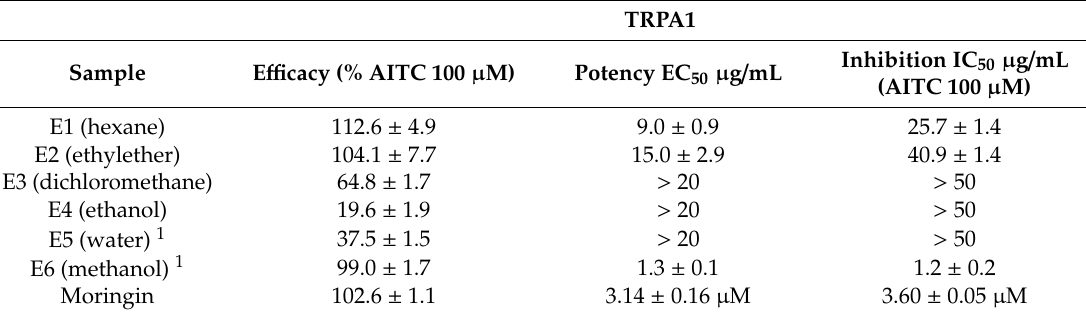
Table 1. In vitro assays on transient receptor potential ankyrin 1 (TRPA1) ion channel.